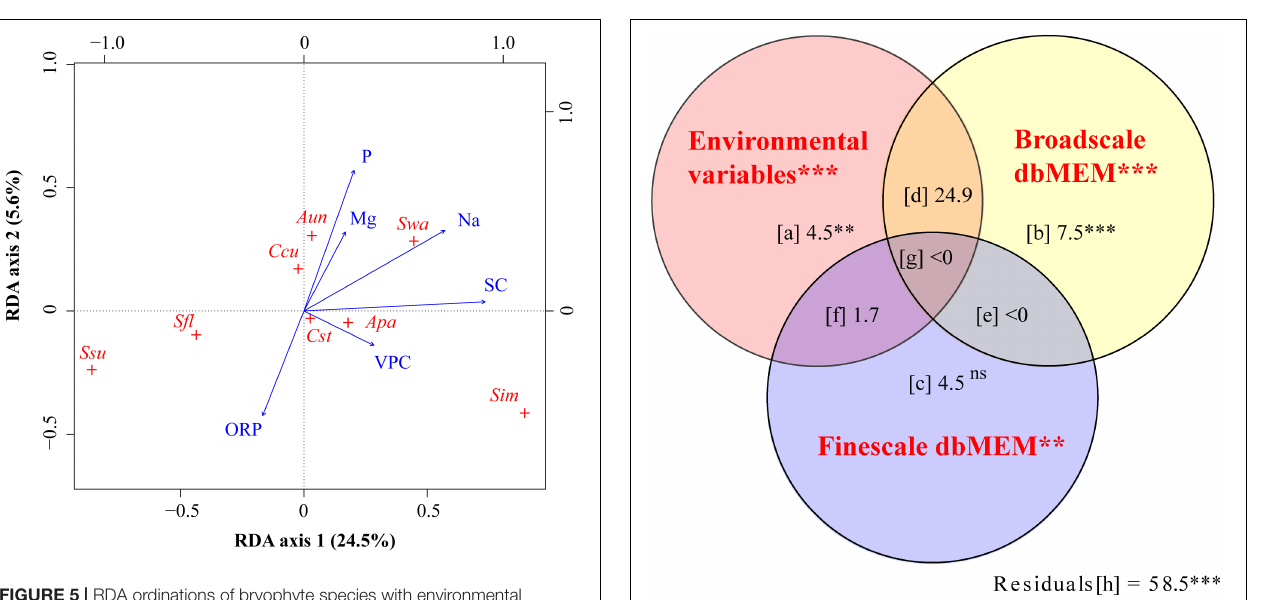
FIGURE 6 | Pure and shared effects of environmental (upper left-hand circle, X1) and spatial variables on the species composition of bryophyte in Jinchuan mire explained by partial redundancy analysis (pRDA) with the Monte Carlo permutation test (Peres-Neto et al., 2006). Spatial variables were separated at two scales: broad scale dbMEM (upper right-hand circle, X2) and fine scale dbMEM (lower circle, X3). When interpreting this variation partitioning diagram, keep in mind that the R 2 adjustment was done for each fraction that can be fitted without resorting to pRDA or multiple regression which included [a], [b], [c], [X1], [X2], [X3], [X1 + X2], [X1 + X3], [X2 + X3], [X1 + X2 + X3], [X1| X2], [X1| X3], [X2| X1], [X2| X3], [X3| X1], [X3| X2], and that the individual fractions [d] to [h] are then computed by subtraction. Fraction [a] represented the variation explained by environment variables alone. Fraction [b], [c], and [e] represented some variation explained by spatial variables independently of the environment. Fraction [d], [f], and [g] represented spatially structured environmental variation. The statistical significance of effects: ns P > 0.05, ∗∗ P < 0.01, and ∗∗∗ P <